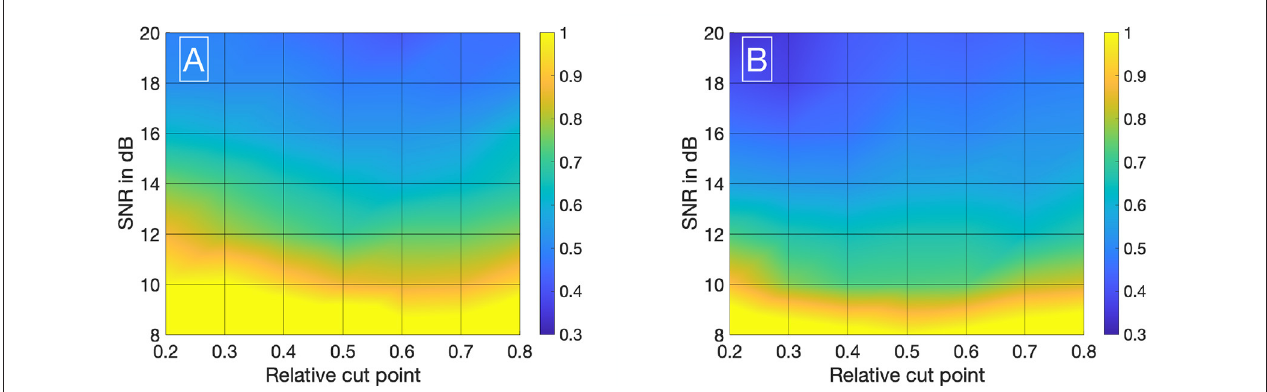
FIGURE 8 | (A) Mean ε frames using the raw data sets ( f sampling applying the cut method 3. (B) Mean ε frames using the linearly interpolated data sets ( f sampling cross-correlation is computed after applying the cut method 2.